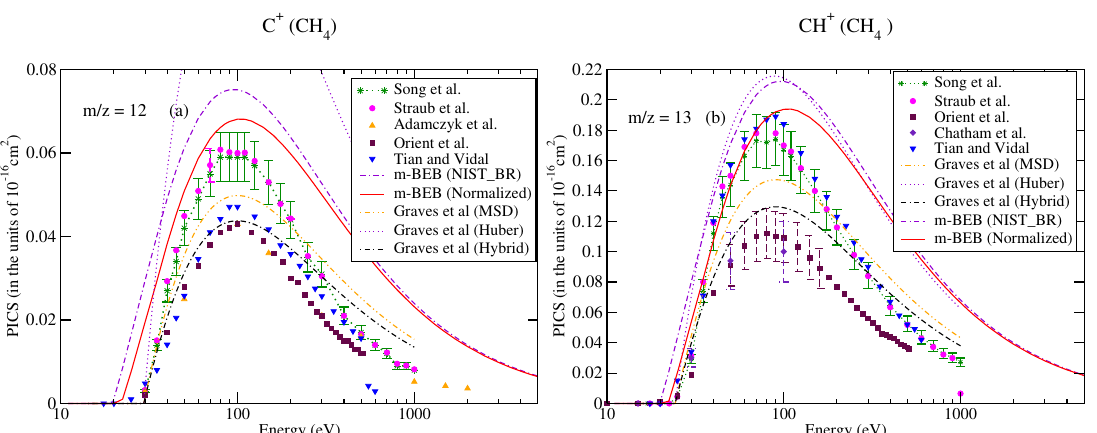
Figure 1. Partial − ionization cross-sections for different fragments of methane: ( a ) m / z = 12, ( b ) m / z = 13. Line curve, m-BEB (normalized); dashed curve, m-BEB (using NIST mass spectrometry data); double dots with dashed curve, Graves et al. [26] from MSD model; dots, Graves et al. [26] from Huber model; dots with dashed curve; Graves et al. [26] from hybrid model; triangles inverted, Tian and Vidal [45]; recommended data of Song et al. [48]; dots with star, circles, experimental data of Straub et al. [50]; triangles, Adamczyk et al. [55]; squares, Orient et al. [56]; diamonds, Chatham et al. [57].